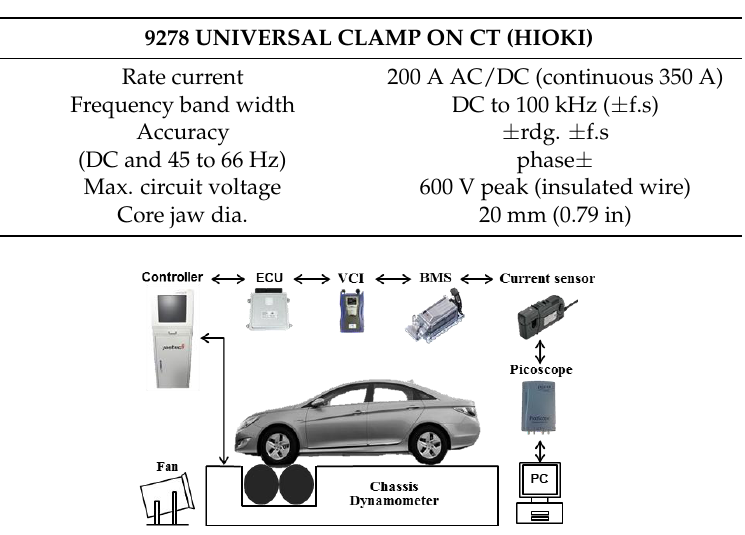
Figure 3. Overall schematic diagram of experimental apparatus.